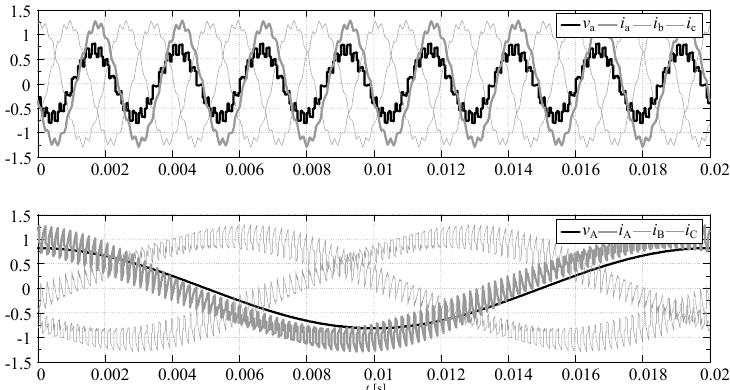
Figure 13. The waveforms of the phase voltages and currents at the output and input of the PWR controlled MMCCR for the S MC n switch state sequences: load model-1, n AB1 = n AB2 = 209/209, n AB3 = 571/209, q = 0.866, k f = 8.